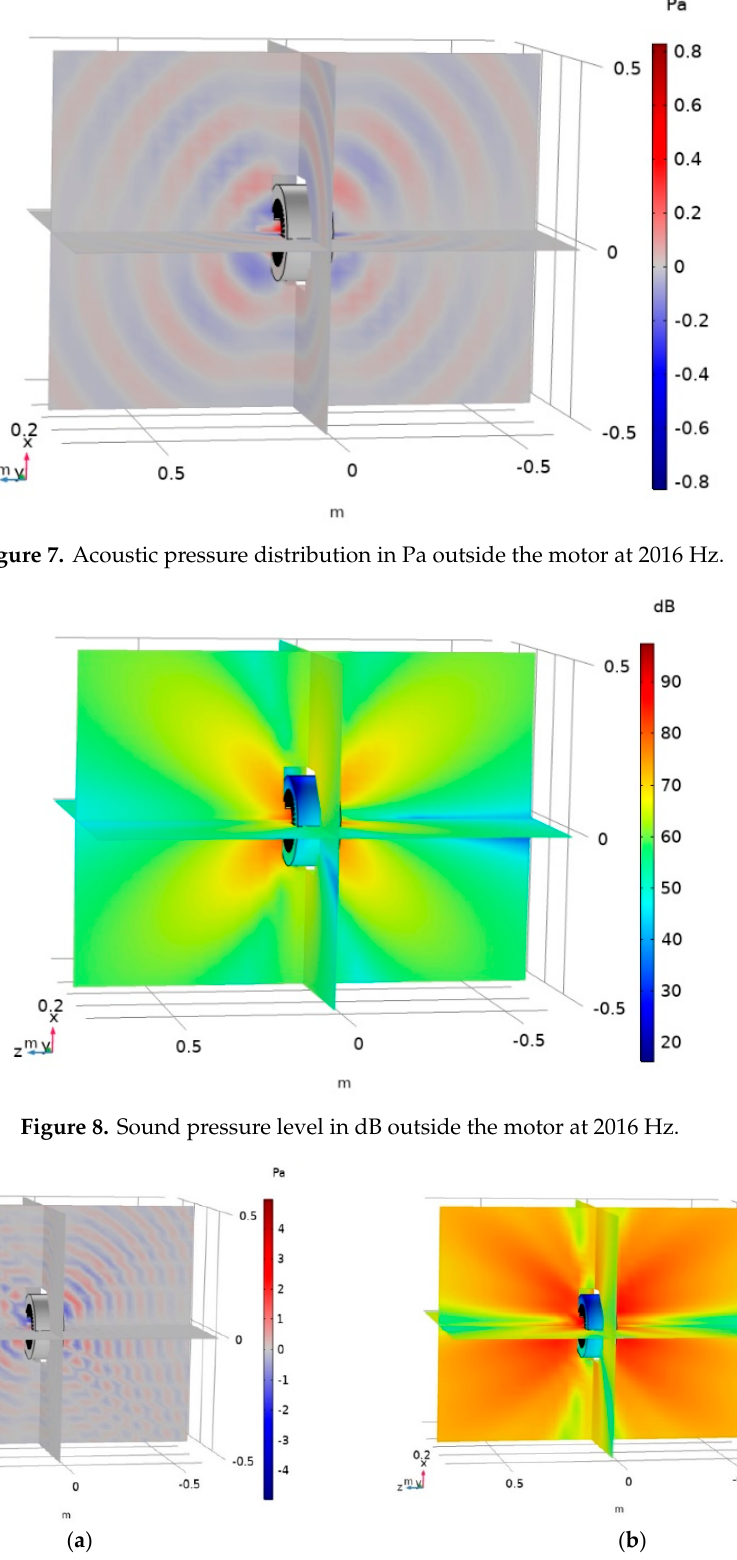
Figure 9. ( a ) Acoustic pressure distribution in Pa outside the motor at 4032 Hz; ( b ) sound pressure level in dB outside the motor at 4032 Hz.